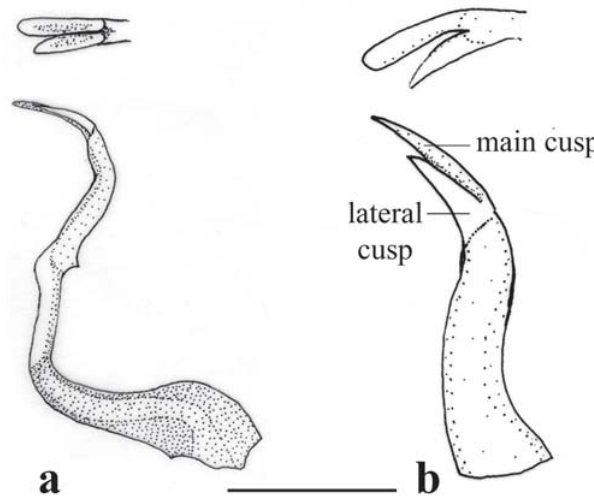
Fig. 32. Lateral view of left premaxillary tooth of Lamontichthys avacanoeiro (MZUSP 61974, 113.7 mm SL, paratype) (a) and Rineloricaria sp. (MZUSP 23748, 91.5 mm SL) (b). Detail of cusps in anterior view. Scale bar = 0.5